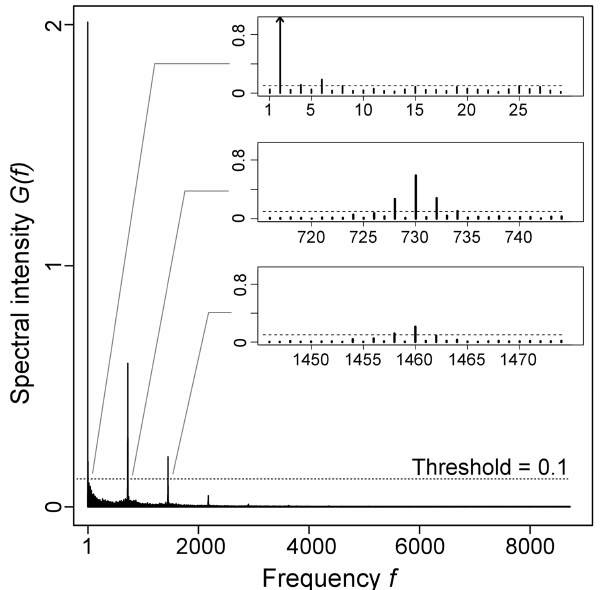
Figure 3. Frequency and spectral intensity of trigonometric curves converted from the 2 years of temperature data at the reference site. Trigonometric curves whose spectral intensity was higher than the threshold value are found in Table 1.